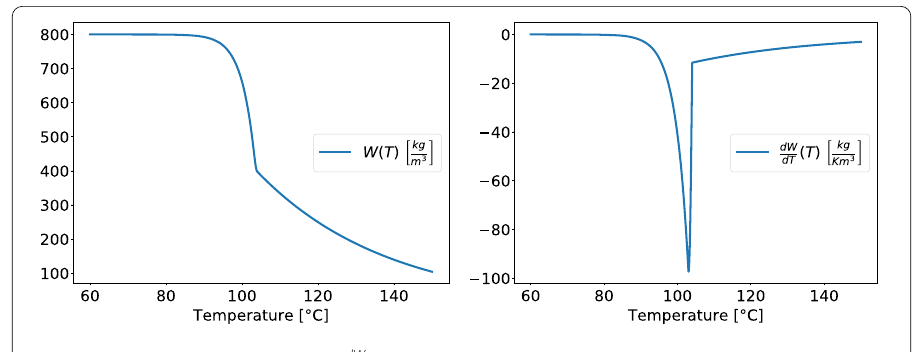
Figure 2 Function W ( T ) and derivative dW